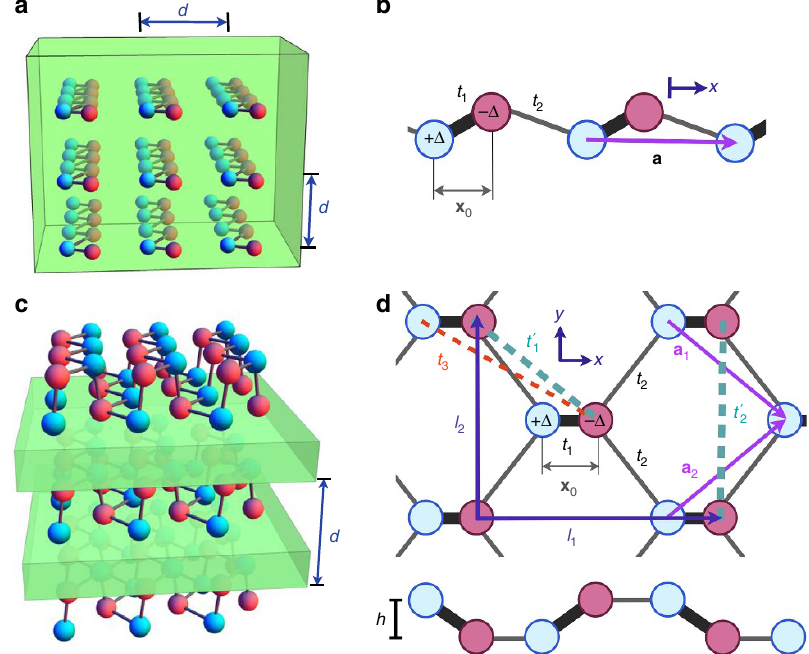
Figure 1 | Schematics of proposed shift current photovoltaics: ( a ) Three-dimensional (3D) structure of a solar cell built by stacking one-dimensional ferroelectric polymers. ( b ) Simplified two-band tight-binding model of a polymer. ( c ) 3D structure of a solar cell made by stacking two-dimensional monolayers of a monochalcogenide. The inert spacers between layers prevent the restoration of bulk inversion symmetry. ( d ) Simplified two-band tight-binding model for a monochalcogenide